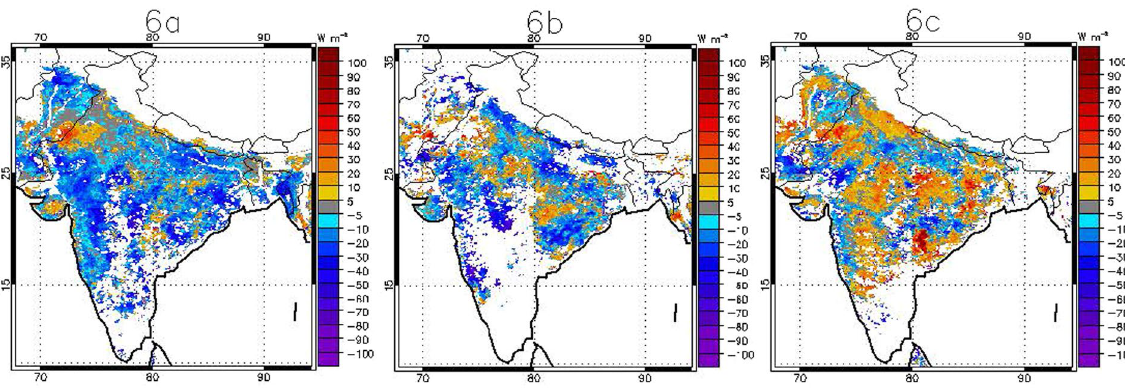
Figure 6. Sensible heat flux anomaly for the weeks of ( a ) May 7 th − 13 th , ( b ) May 14 th − 20 th and ( c ) May 28 th – June 4 th from ALEXI (see text for details of the dataset) based on the weekly climatology of 2003–2015. The anomaly plot for the weeks of May 21 st − 27 th and June 5 th − 11 th are not shown due to the large extent of missing data resulting from cloud-contamination in satellite inputs to ALEXI. ALEXI provides 7-day composite data where calendar dates for each of the 7-day periods are pre-defined. Any pixel with elevation above 1000 m is not shown (white colored region). White color also shows pixel with missing values. Data visualizations produced using IDL [8.4] (Exelis Visual Information Solutions, Boulder,